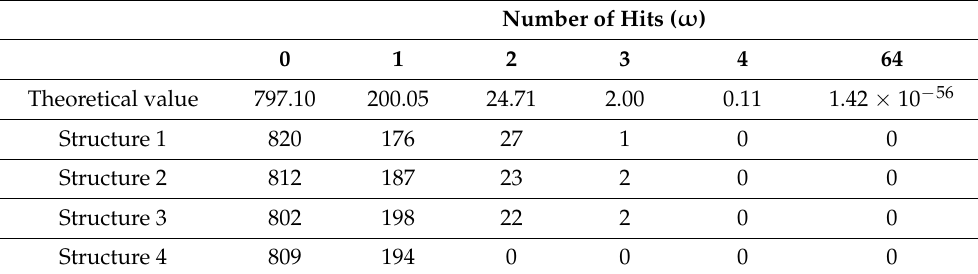
Table 13. Number of hits for all structures of the proposed hash function for N = 1000.